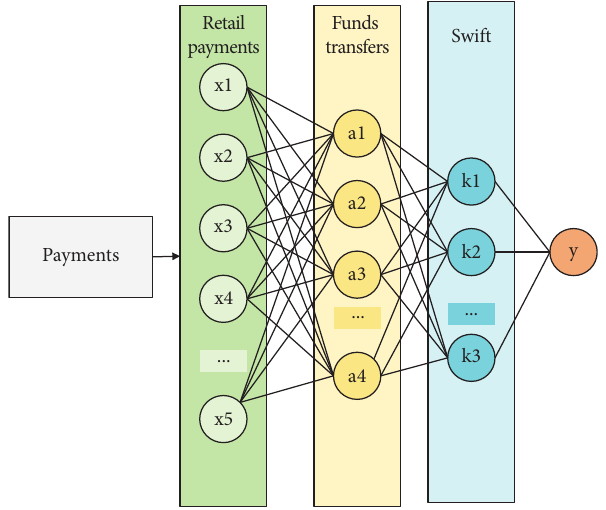
Figure 3: Coupling between financial